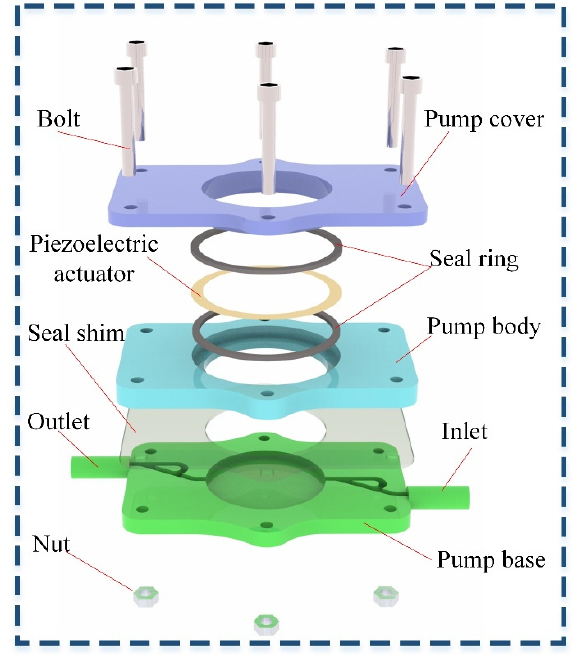
Figure 1. Structure of the valveless piezoelectric pump with Tesla valve assembly.